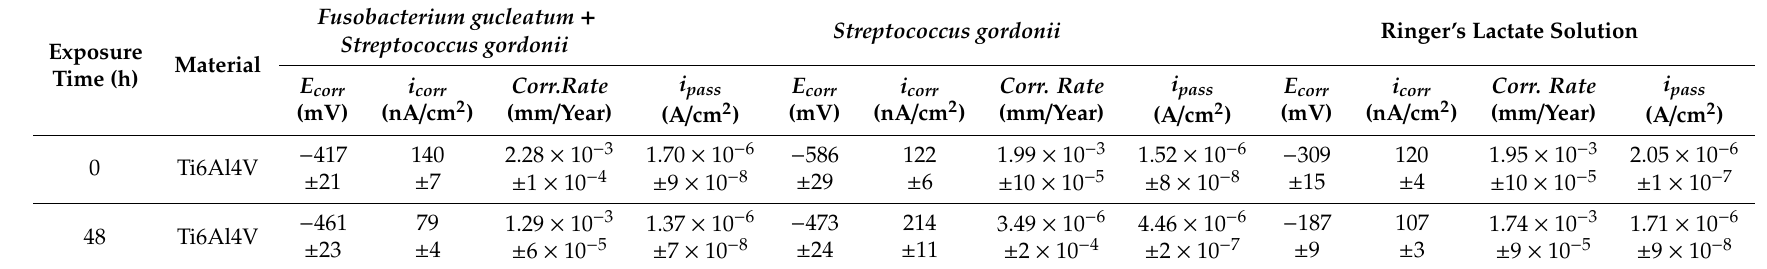
Table 4. Electrochemical parameters using cyclic potentiodynamic polarization of the Ti6Al4V